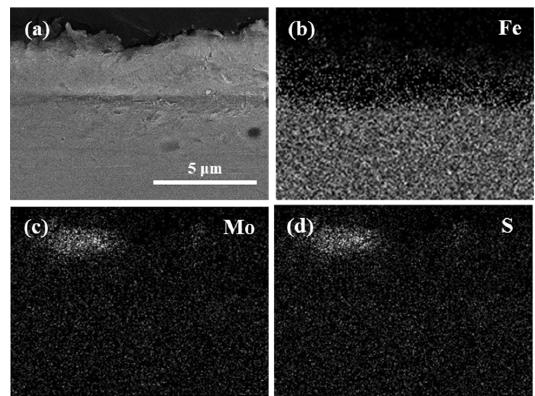
Figure 3. Cross sectional images of SunFO with MoS 2 coating on the SS observed by SEM and EDS: ( a ) 10000× (Cross-section of the specimen), ( b ) Fe observed by EDS mapping, ( c ) Mo observed by EDS mapping, ( d ) S observed by EDS mapping.